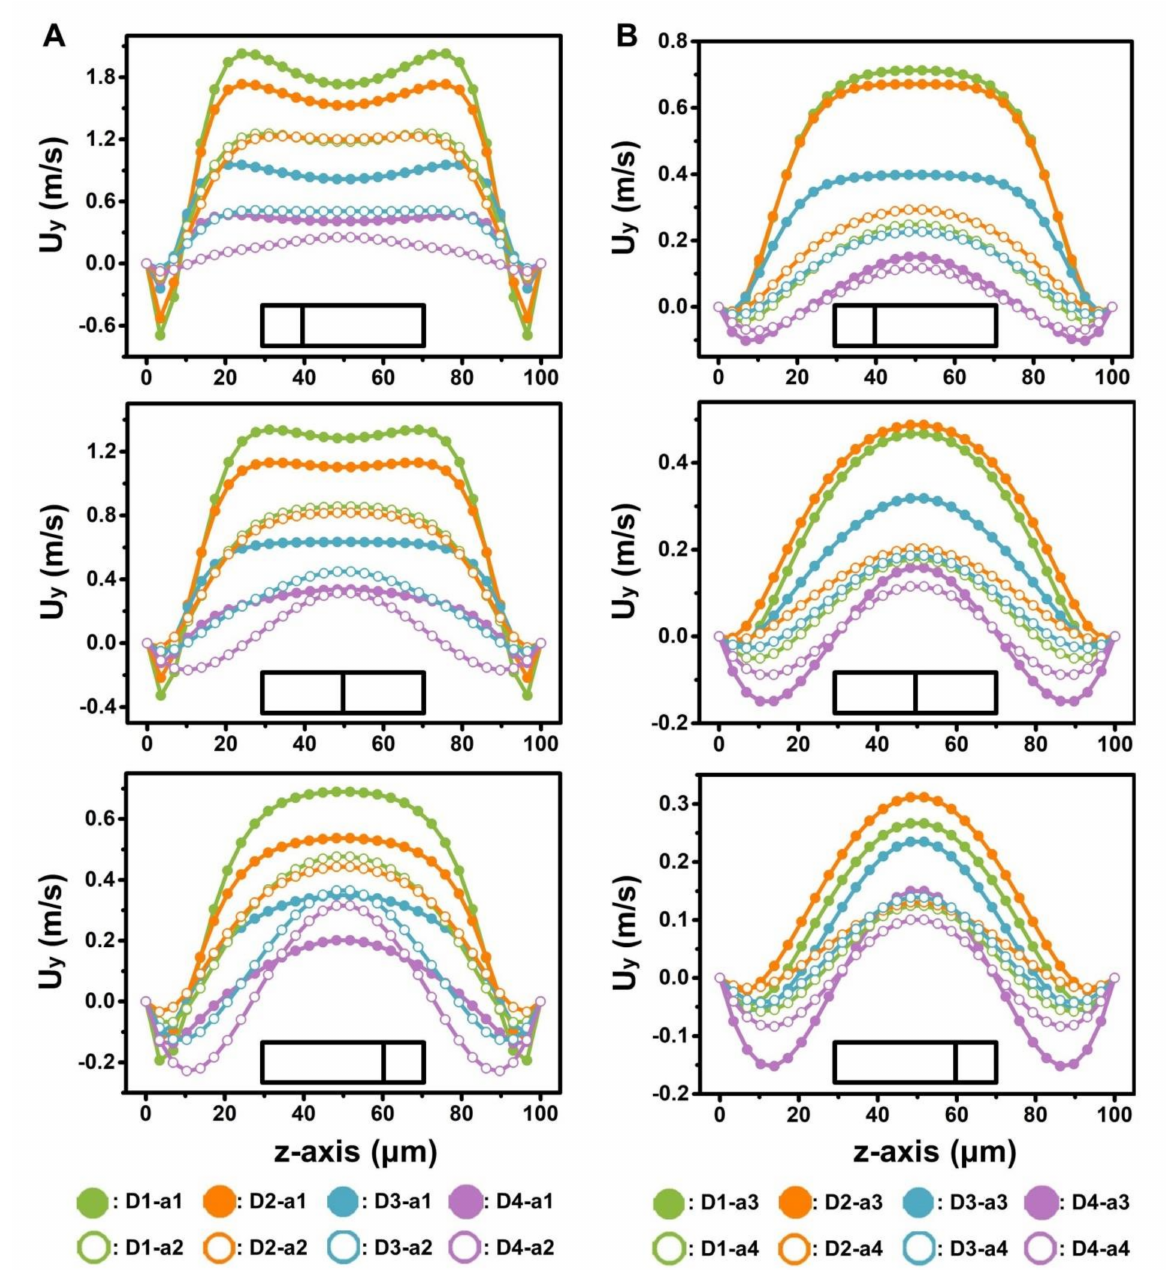
Figure 7. ( A , B ) Quantitative analysis of fluid velocity along channel cross sections of D-channels (D1, D2, D3, D4) with different widths of the narrow regions (a1 ( A ), a2 ( A ), a3 ( B ), a4 ( B )) at a flow rate of 15 mL min − 1 . The results correspond to the solid lines in Figure 6. a1, a2, a3, and a4 represent 270, 450, 630, and 810 µ m widths of the narrow regions in Figure 1A